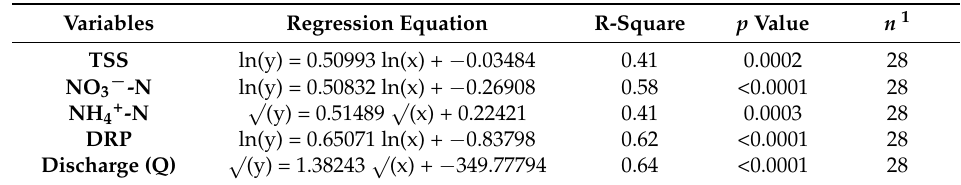
Table 4. Equations used to calculate Event Mean Concentrations (EMCs) established from 28 storm events collected from November to May during the calibration